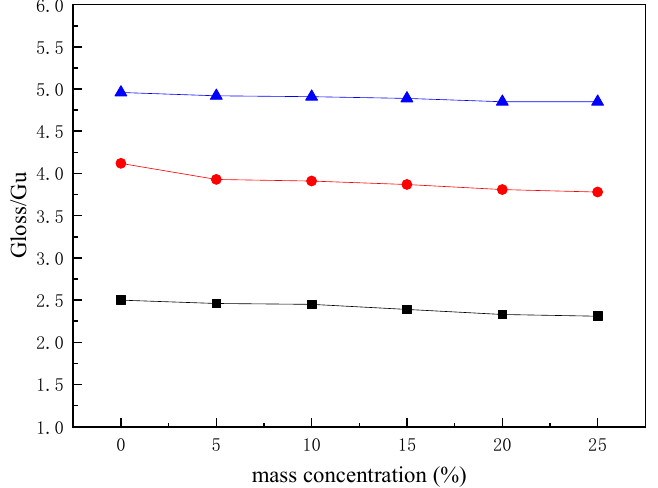
Figure 7. Gloss of the paper treated with different mass concentrations of polyurethane. ■ , G20; ●, G60; ▲ , G75.